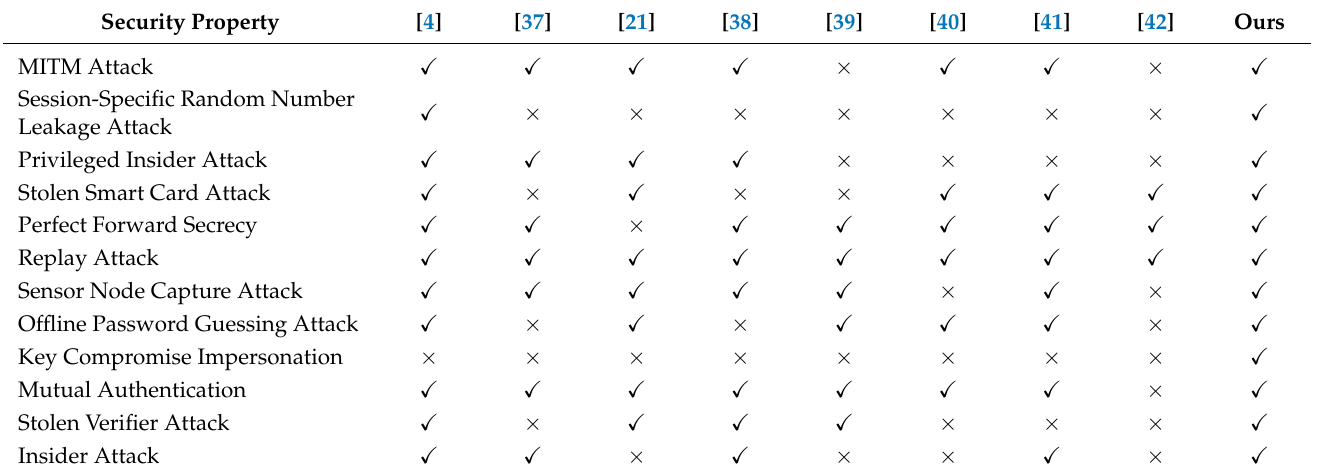
Table 12. Security